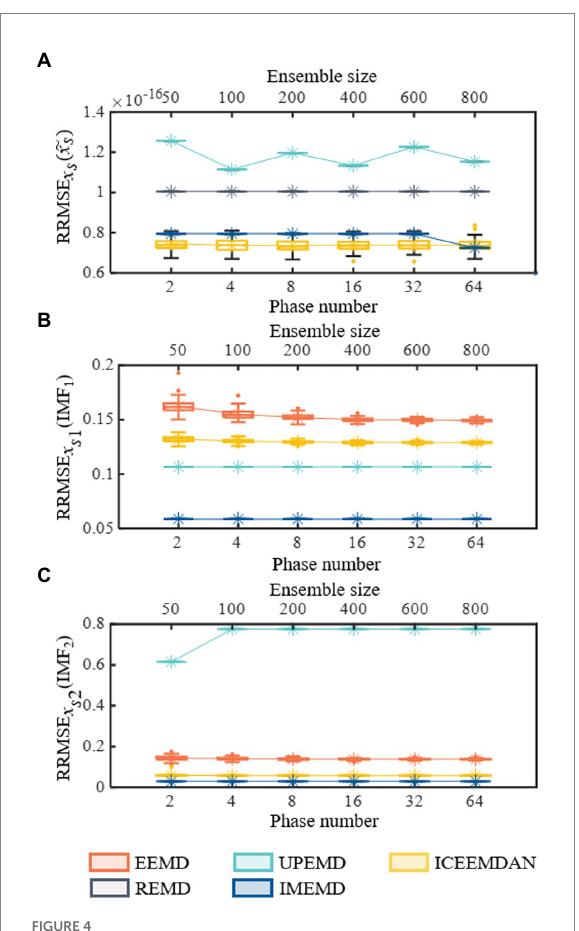
FIGURE 4 Performances of recovering known components on synthetic signal x s ( t ). All five methods are decomposed 100 times to obtain the statistical average results and shown using boxplots. (A) Reconstruction errors of synthetic signal x s ( t ). (B) Performances of recovering x s 1 ( t ). (C) Performances of recovering x s 2 ( t ). In each subgraph of (A–C) , the symbol “*” represents the mean value of the corresponding 100 decomposition